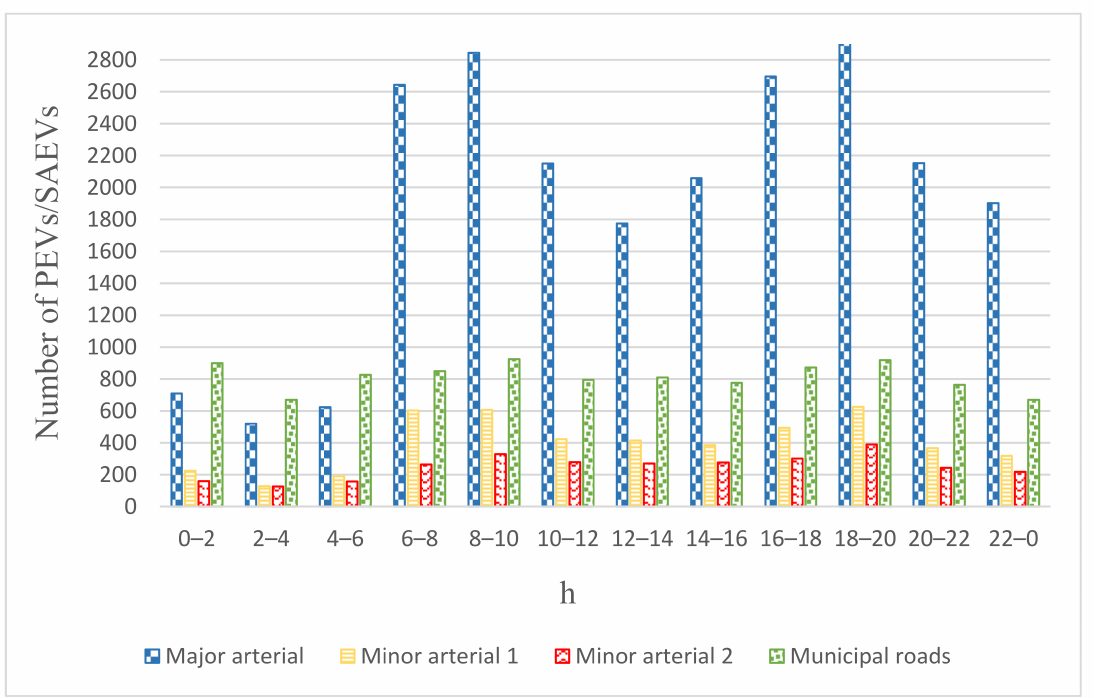
Figure 7. Traffic volumes of all road sections after applying real time rideshare